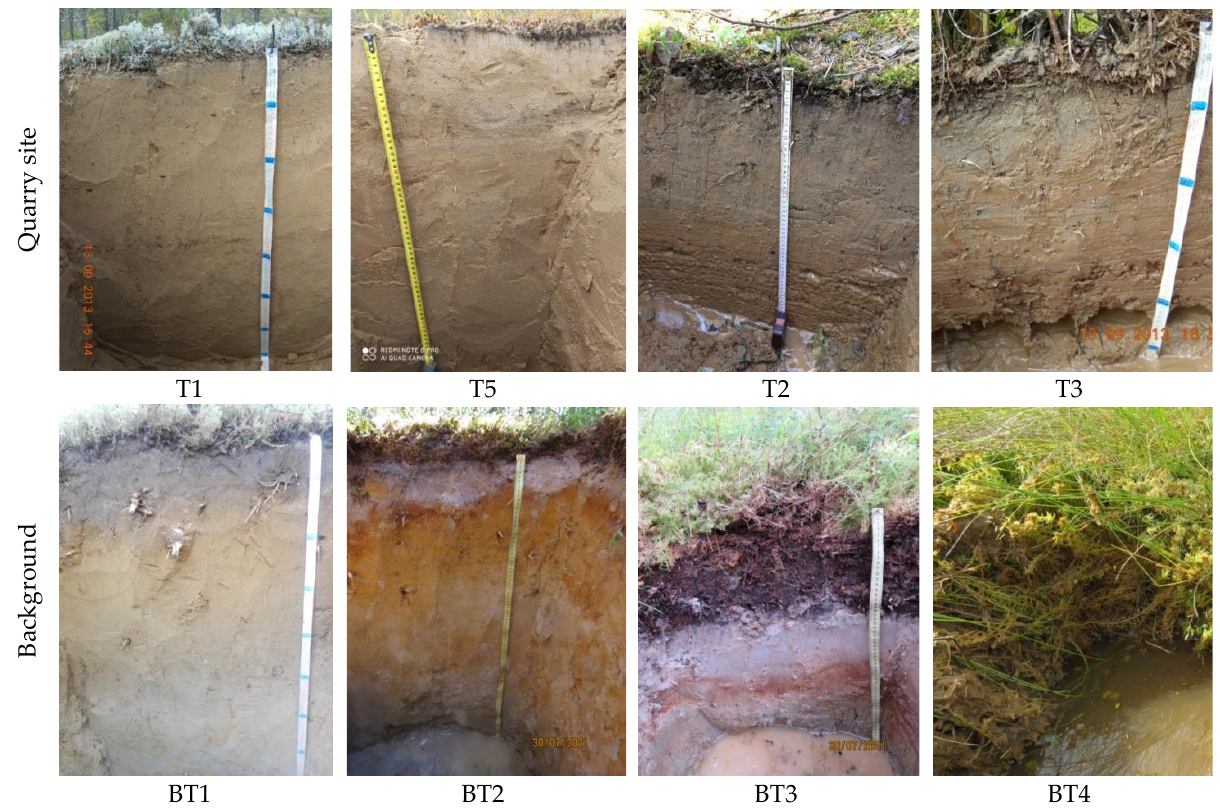
Figure 1. A series of soil pits show the soils of quarry site and background site. All abbreviations are explained at Table 1.